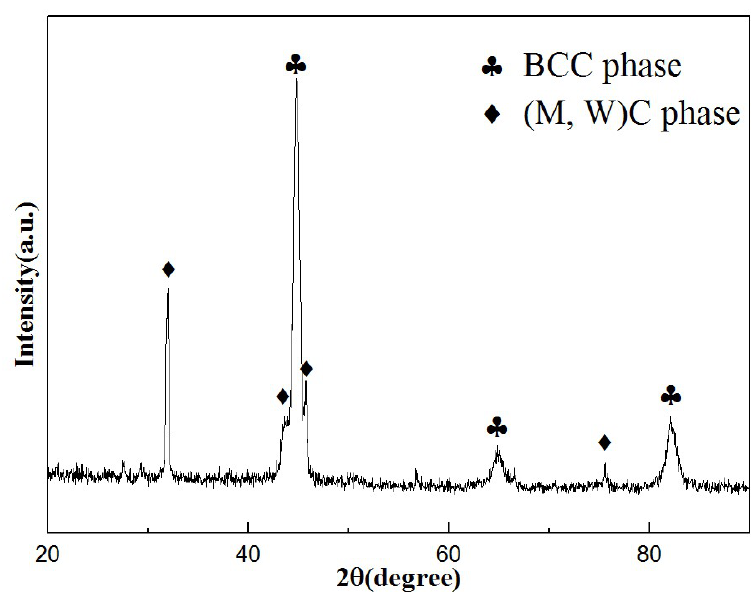
Figure 5. XRD pattern of the laser-cladded AlCoCrFeNi/WC coating.